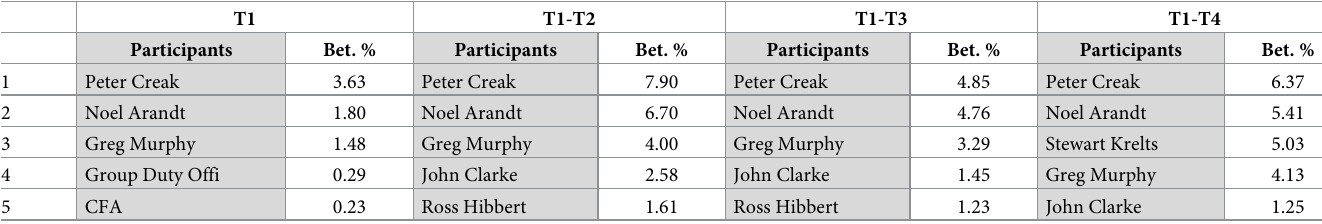
Table 5. Top 5 intermediating participants (brokering between actors): Normalized betweenness centrality. T1